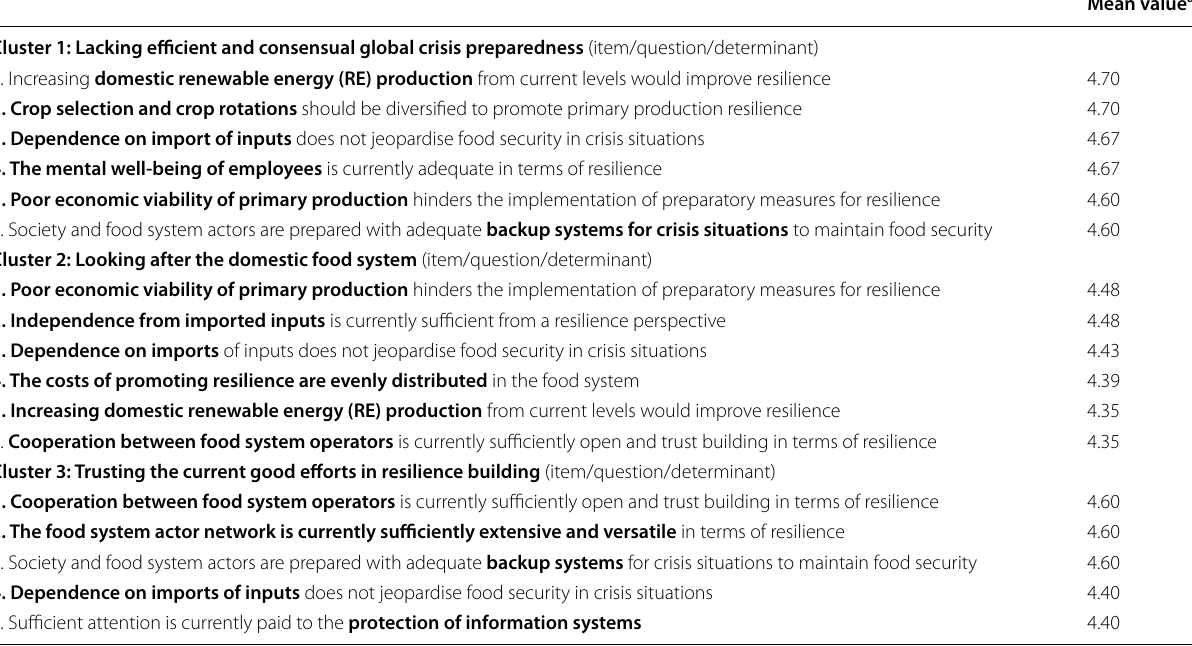
Table 2 The five most important resilience items/questions/determinants (the bold text is used to highlight the item/issue/topic in question)